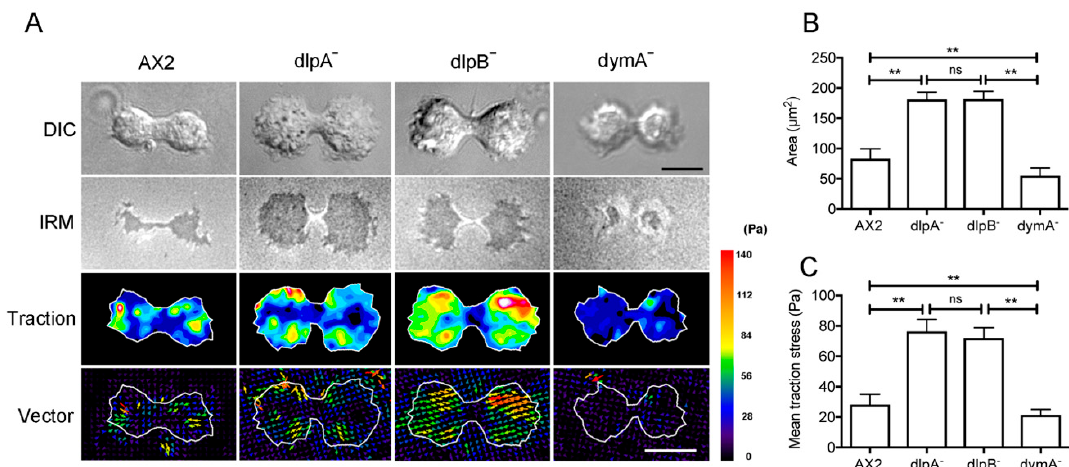
Figure 6. Dynamins contribute to cell-substratum adhesion and traction force. ( A ) Typical DIC images, interference reflection microscopy (IRM) images, traction maps, and traction vector maps of dividing cells (A × 2, dlpA - , dlpB - , and dymA - ). Each arrow in the traction vector map indicates both the magnitude and direction of the traction stress. The color code indicates the magnitude of the traction stresses; Bar, 10 µ m. ( B ) Comparison of the cell-substratum adhesion area among these cells ( n = 15, each). ( C ) Comparison of the mean traction stresses among these cells ( n = 15, each). Data are presented as mean ± SD and analyzed by one-way ANOVA with Tukey’s multiple comparison test. ** p ≤ 0.001; ns, not significant, p > 0.05.